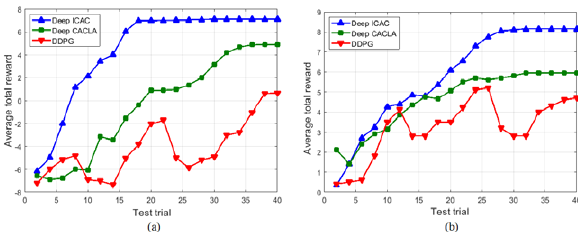
Figure 5: Performance curves of Deep ICAC, Deep CACLA, and DDPG on the robotic environment of the learning-to-reach task in different reward settings: dense-reward (a) and sparse-reward